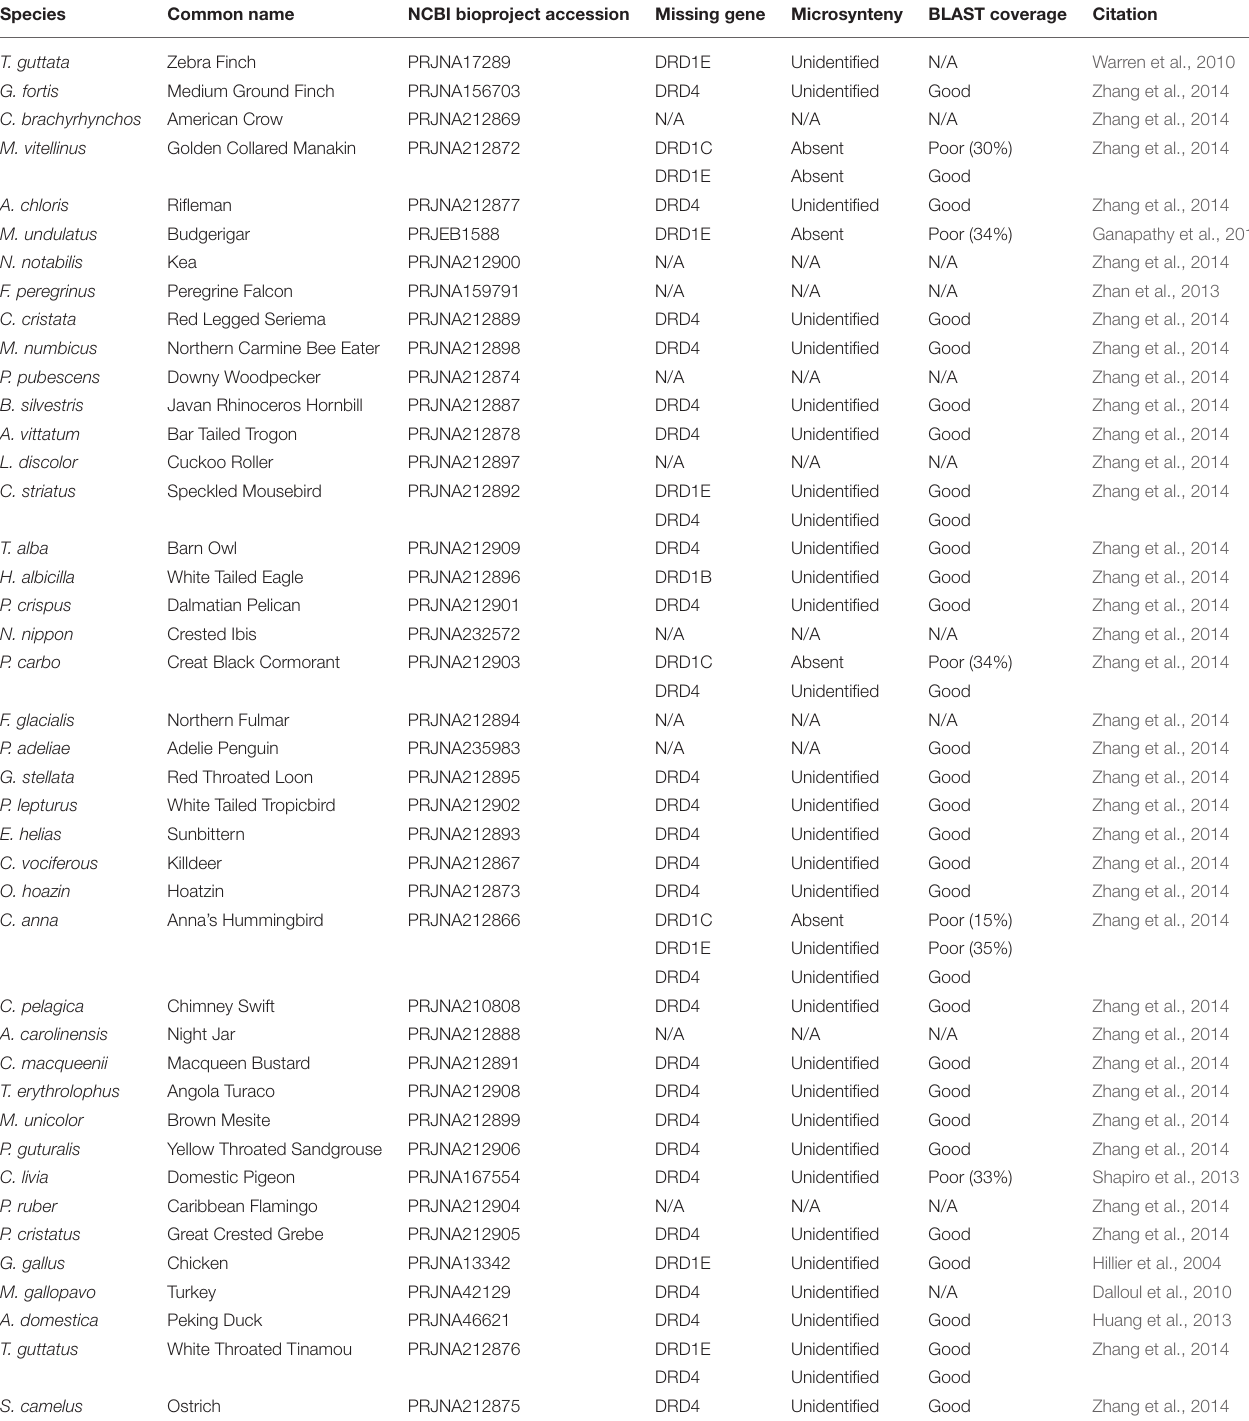
TABLE 1 | Avian genome information and summary of gene absence confirmation by microsynteny and BLAST searches of raw sequencing reads.